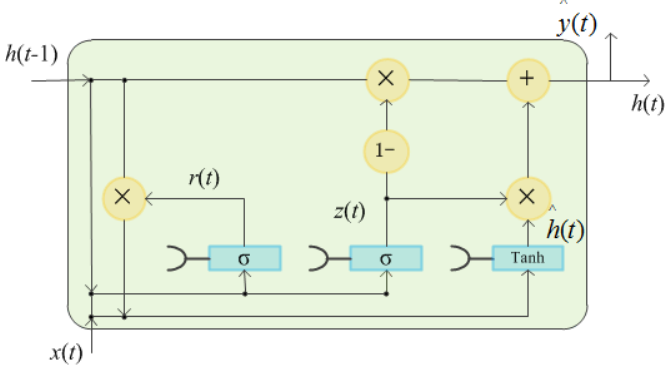
Figure 5. The architecture of the gated recurrent unit.